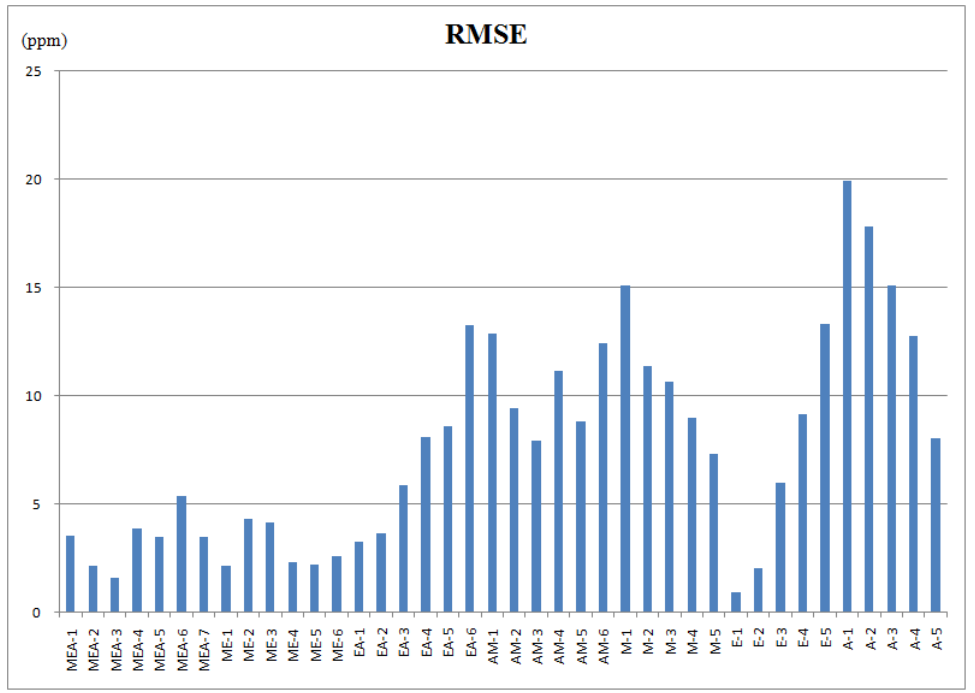
Figure 7. The root mean squared error of all the estimated results in Tables